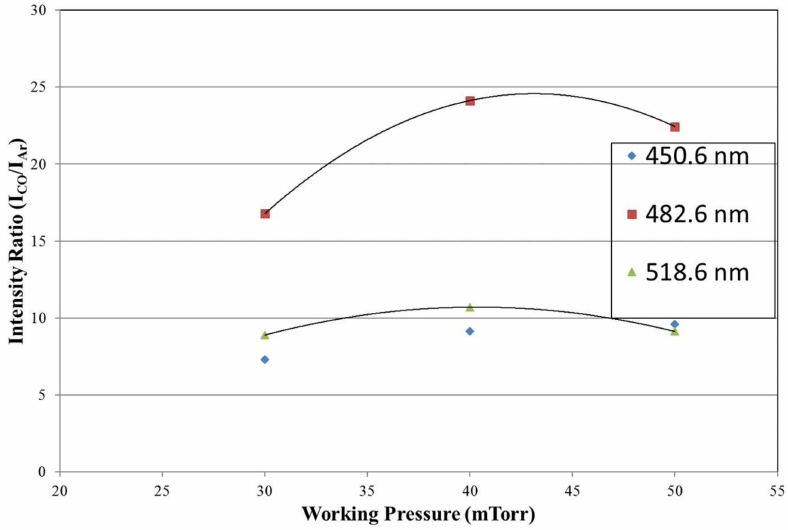
Figure 12. OES intensity ratio of Ar peak to CO peaks vs. working pressure.